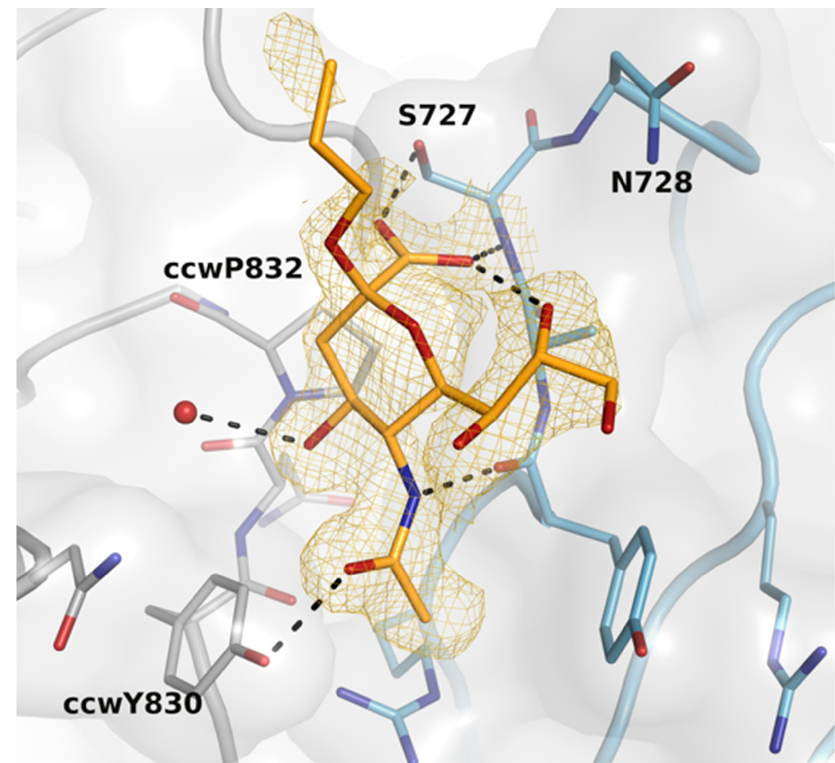
Figure 3. Binding of compound 14 to CVA24v. Interactions of the Neu5Ac moiety of compound 14 to amino acids in the ligand binding sites of CVA24v. The binding site located at the interface of two lectins proteins (light blue, light grey) is occupied by the sialic acid entity (orange) of the inhibitor as shown by an unbiased simulated annealing (Fo-Fc)-map (light orange) depicted at a contour level of 2.5 σ . The spacer to the corannulene core is flexible, resulting in a fuzzy electron density. Therefore, neither the corannulene nor most parts of the spacer can be modeled into the crystal